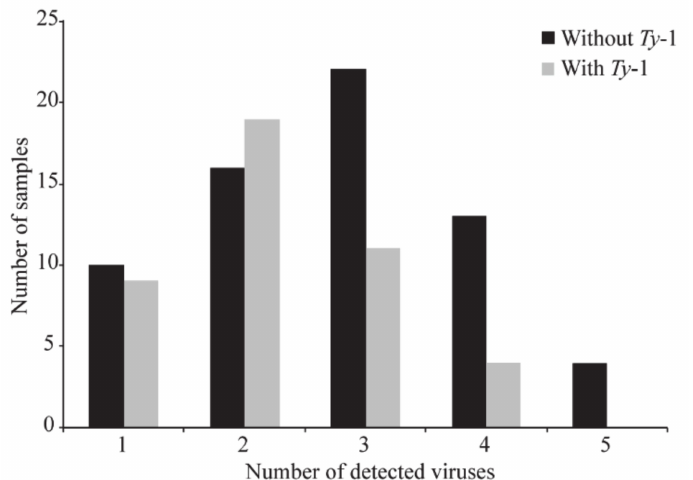
Figure 2. Number of samples displaying single and mixed (ranging from two to five viruses per sample) infections with Begomovirus species and single-stranded DNA viruses detected with Illumina Hiseq sequencing of tomato samples with ( n = 43) and without ( n = 64) the Ty -1 gene. Results were validated by PCR assays with virus-specific primers and by Sanger dideoxy